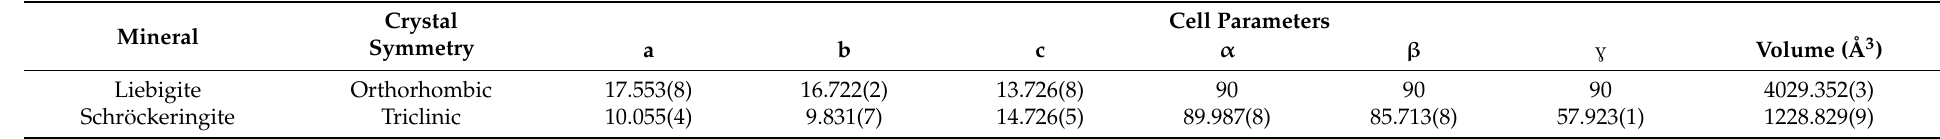
Table 6. Unit cell parameters of uranyl carbonates from Podg ó rze mine.